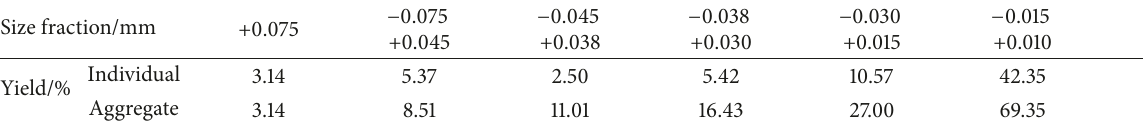
Table 2: Particle size distribution of samples.